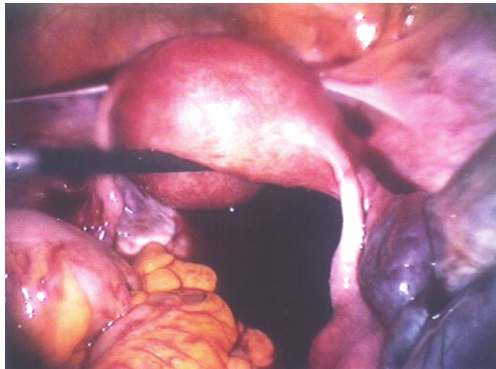
Figure 1: Laparoscopic photograph of right adnexal torsion at the utero-ovarian